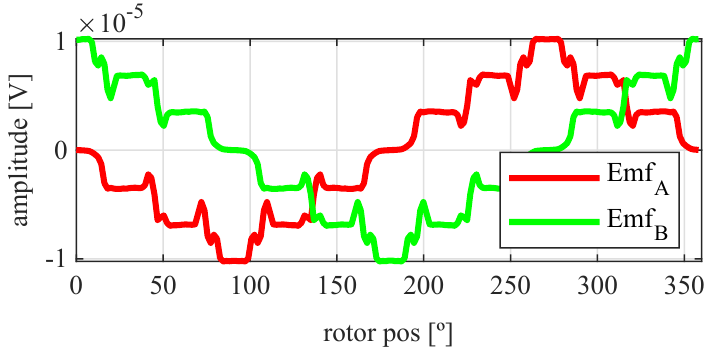
Figure 23. Full pitch twelve-slot resolver EMFs with the least THD.